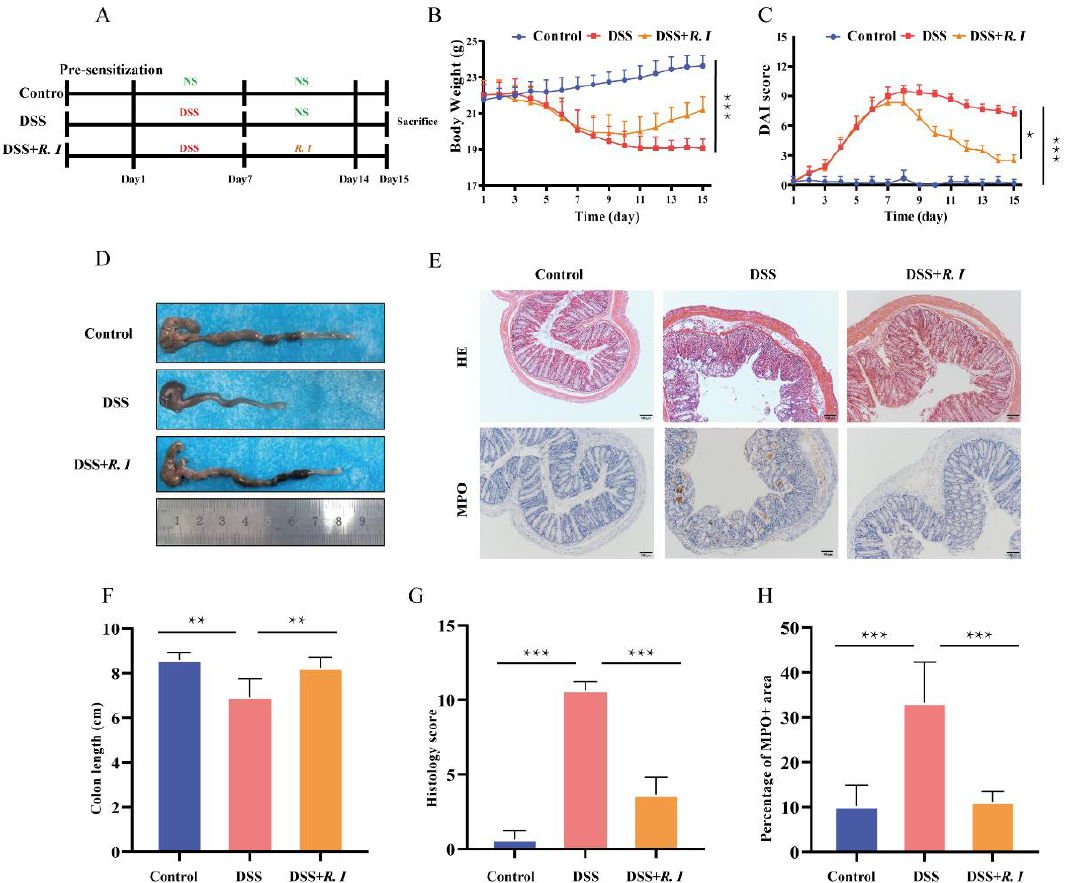
Figure 1. Mice with DSS-induced intestinal damage and clinical symptoms treated with R. intestinalis . ( A ) Schematic of the effect of R. intestinalis on DSS-induced colitis in mice. ( B ) The disease activity index (DAI) scores of the control, DSS, and DSS + R. I treated mice. ( C ) The body weights of mice in the three groups are plotted and presented as the mean. ( D ) Illustration of the colons of the mice in each of the three groups. ( E ) H&E staining for the three groups. Representative images of MPO immunohistochemical staining of colon sections from the three groups. ( F ) On Day 15, the colon lengths of the three groups were measured. ( G ) The histology score of H&E staining. ( H ) The percentage of MPO + area. The statistics are presented as the mean ± SD of three replicates; * p < 0.05, ** p < 0.01, and *** p < 0.001.